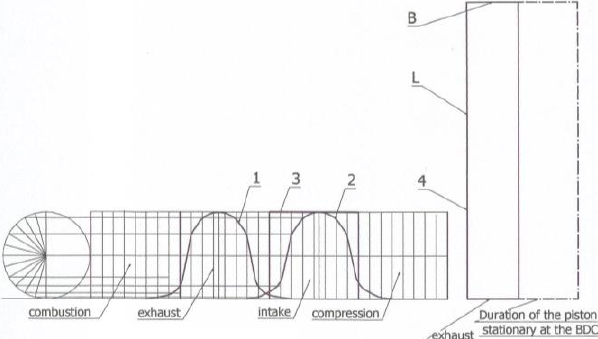
Fig. 11. Displacement diagram of valves: 1 – displacement diagram and an effective area of the exhaust valve in the traditional engines, 2 – displace- ment diagram and an effective area of the intake valve in the traditional engine, 3 – displacement diagram and an effective area of the intake Fig. 10. Variation of the moments in the new engine and (connecting) valve in the proposed engine, 4 – an affective area of aperture traditional one for exhaust and exhaust duration when the piston is stationary at the BDC, L – length of apertures, B – width of The new engine must be equipped with efficient fly- wheels to compensate for the uneven rotation.